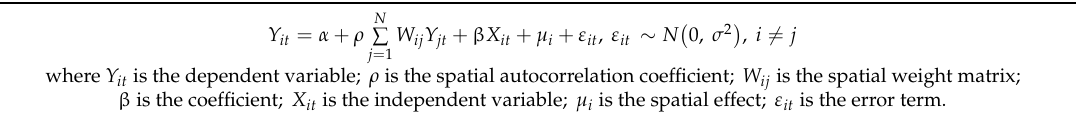
Table 5. The results of spatial autoregressive model